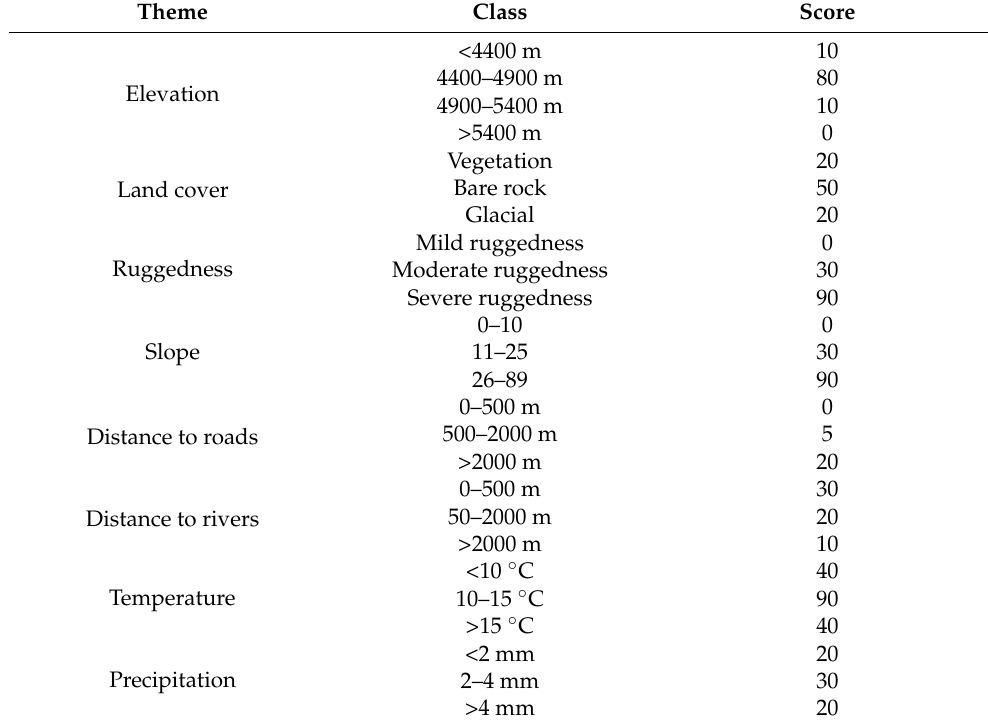
Table 1. Class and scores are used to map dispersal